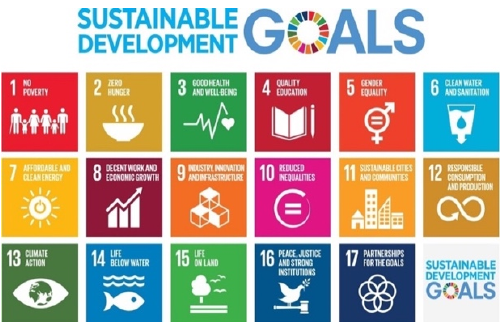
Figure 5. The 17 Sustainable Development Goals identified by science research and policy panels gathered around the United Nations interagency system as the global priority. Source: